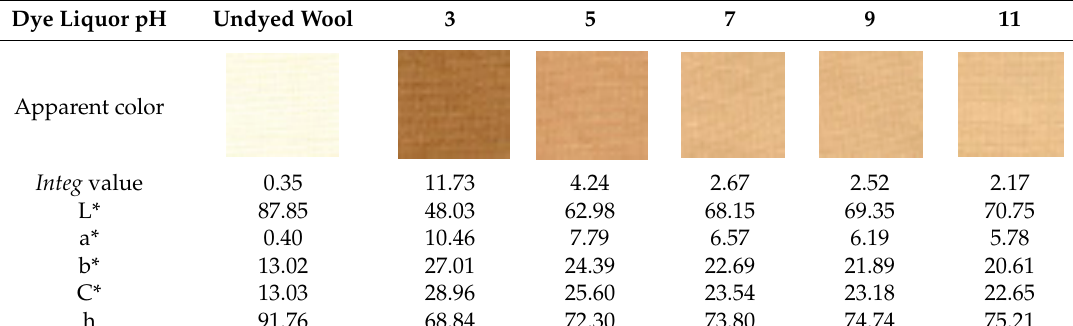
Table 3. The color parameters of dyed wool fabrics with tea polyphenols.